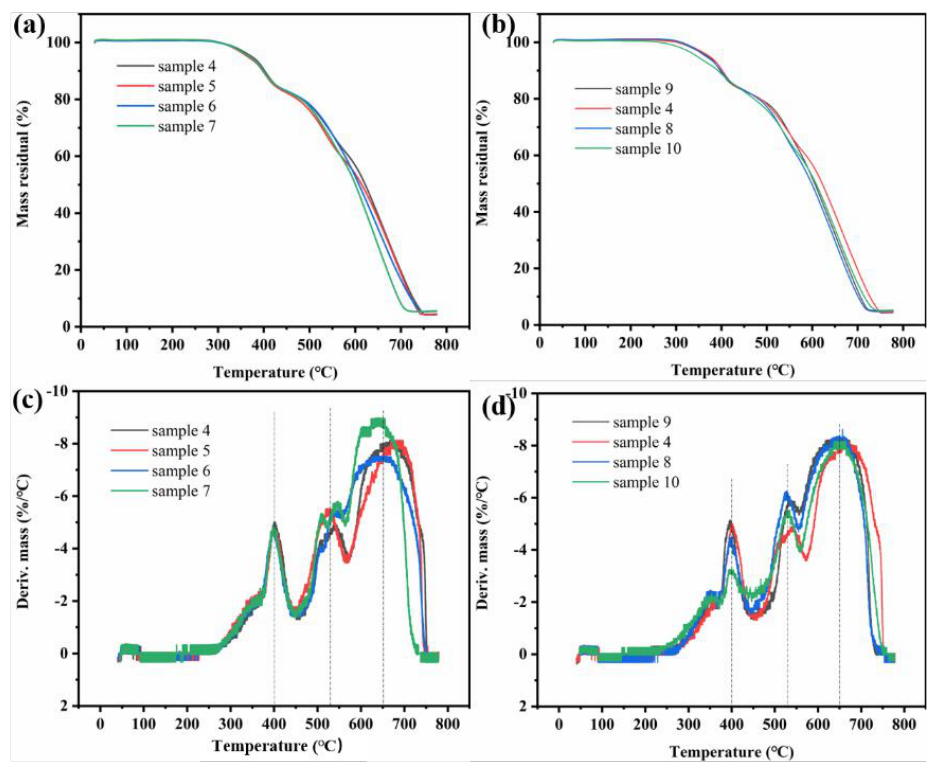
Figure 7. TGA curves of ( a ) sample 4 – 7 and ( b ) sample 9, 4, 8, 10; DTG curves of ( c ) sample 4 – 7 and ( d ) sample 9, 4, 8, ( d ) sample 9, 4, 8, 10.